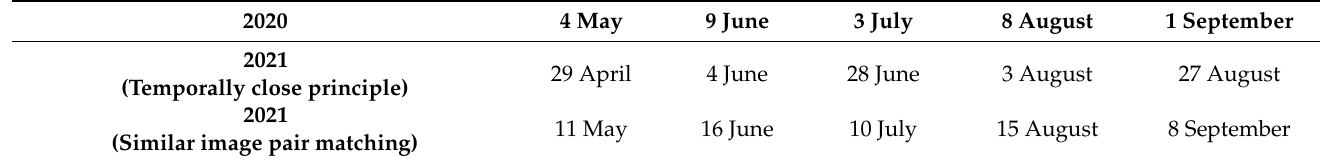
Table 6. The similar image pairs between 2020 and 2021.